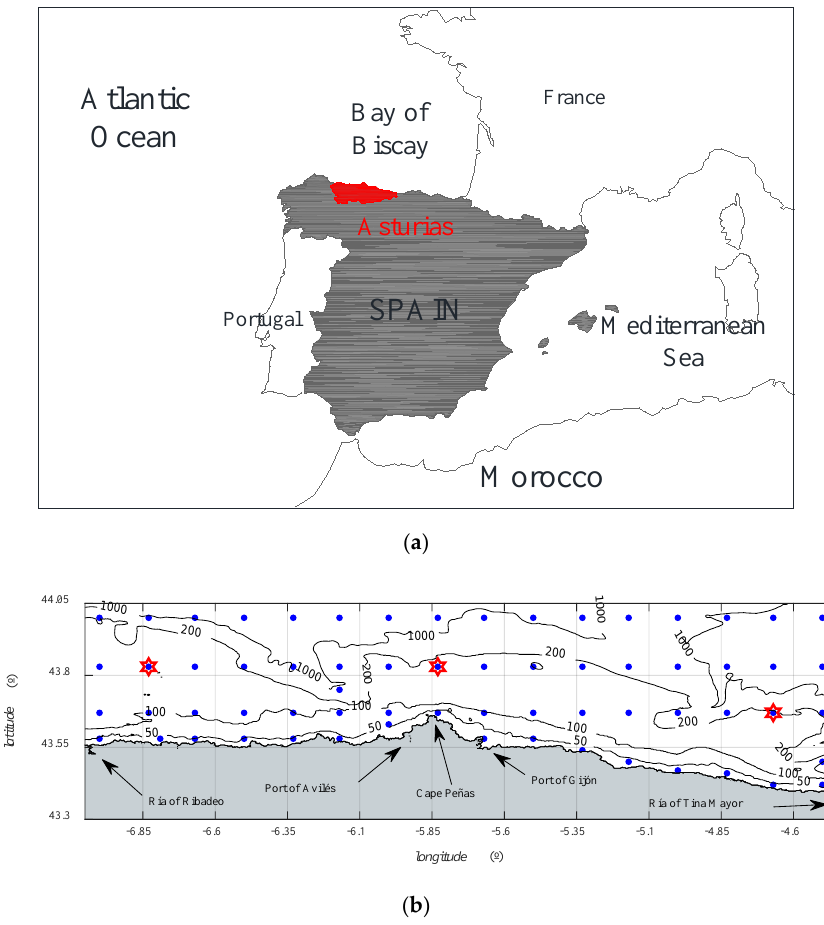
Figure 3. Location ( a ) and bathymetry ( b ) of Asturias. SIMAR data points are marked with blue dots, and the three study sites (West, Centre and East) with red stars. (Water depths in m).